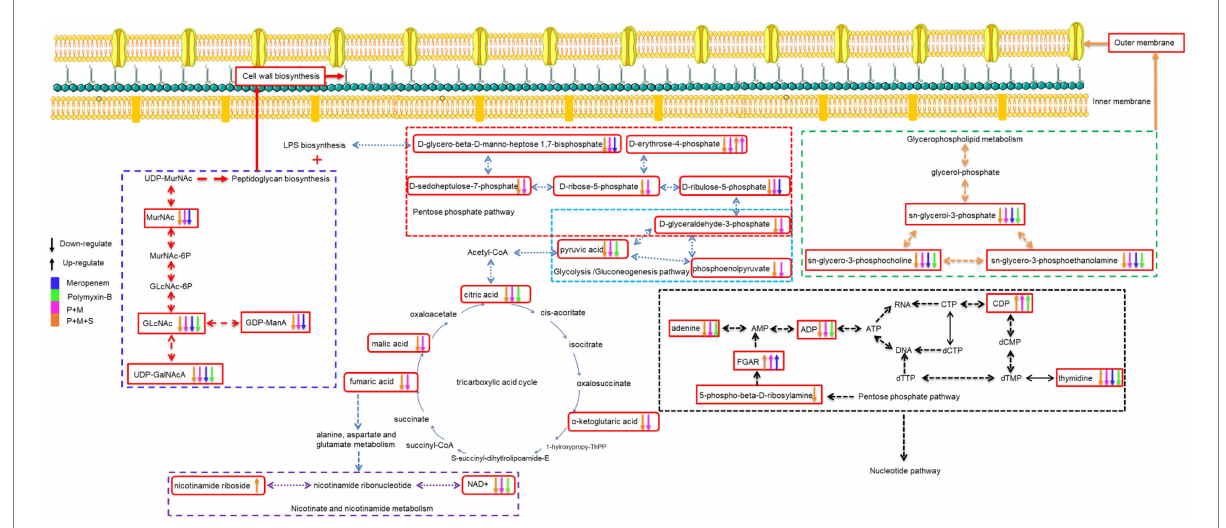
FIGURE 6 Illustration of affected metabolomic pathways in Acinetobacter baumannii treated with antibiotics as monotherapy and combination